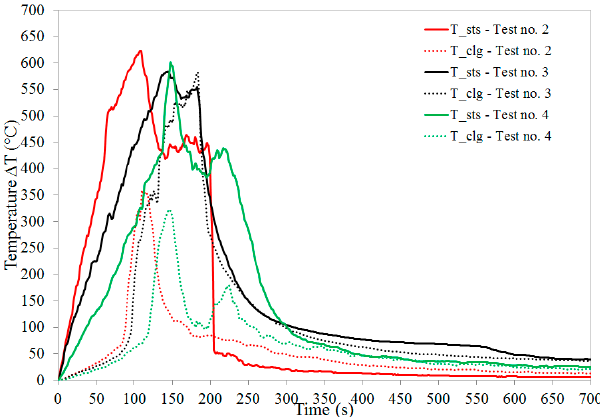
Figure 9. Timber–bench and ceiling surface temperature trends for Tests no. 2–4. Figure 9. Timber-bench and ceiling surface temperature trends for Tests no.